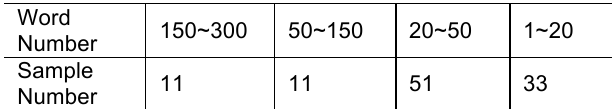
Table 8 Statistics of Test cases